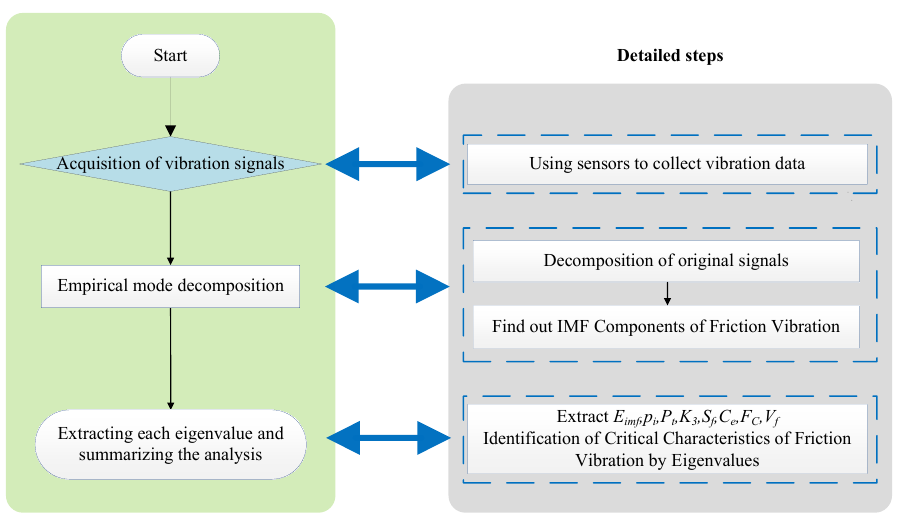
Figure 1. Identifying the flow of friction-induced vibration characteristics in WLBs.